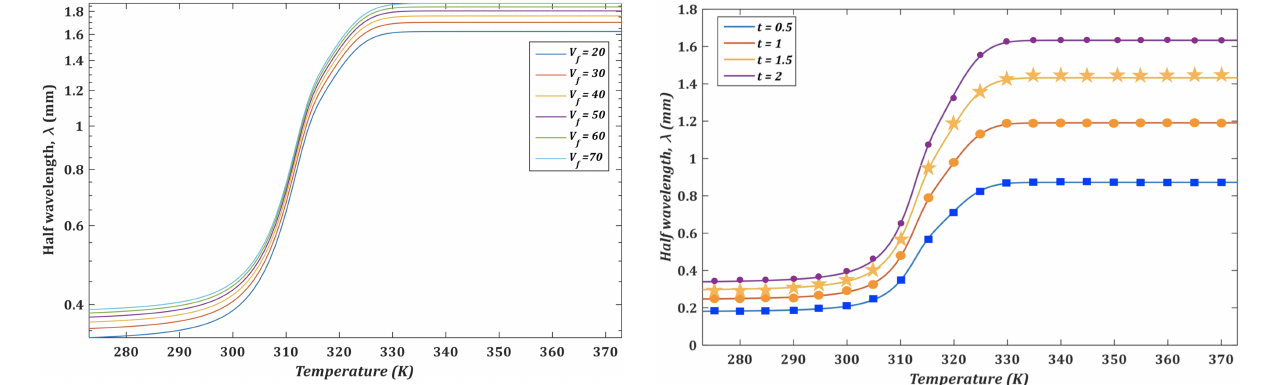
Figure 15: Variation of the half wavelength ( λ ) with respect to tem- perature ( T ) at t from 0.5 to 2